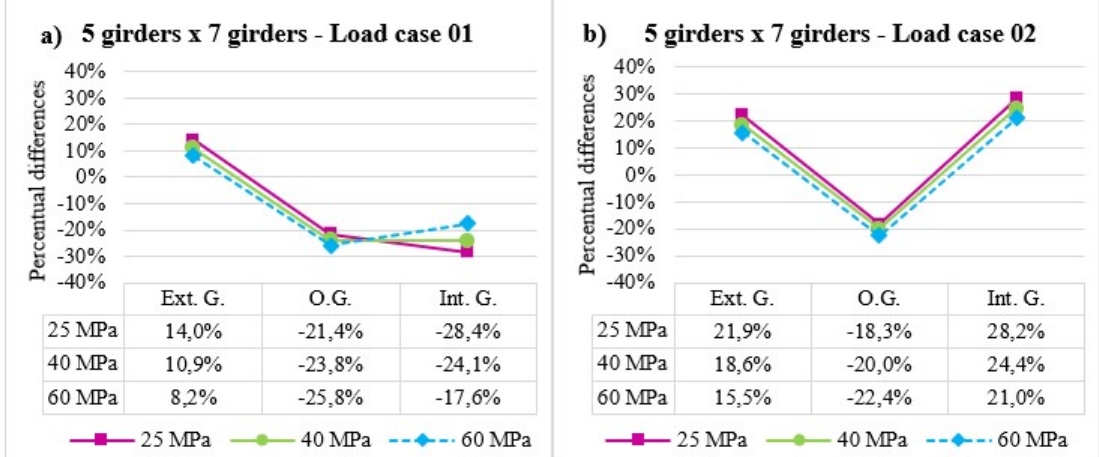
Figure 14. Local analysis between the BMDF's of the 5-girder and 7-girder models: (a) Load case 01; (b) Load case